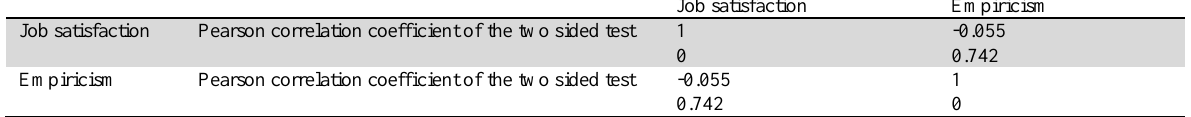
The results of Pearson correlation test for the fourth hypothesis